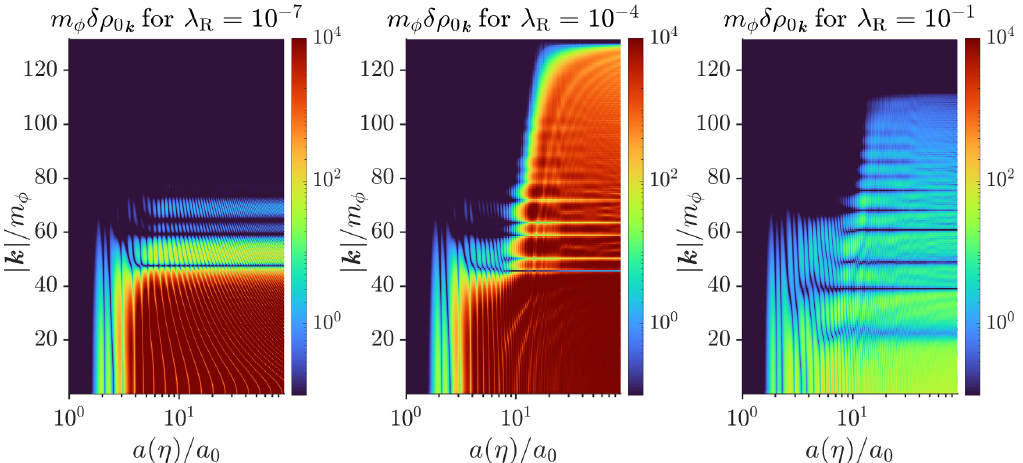
Figure 3 . The zeroth moment δρ 0 k of the two point function for λ R ∈ { 10 − 7 , 10 − 4 , 10 − 1 } with ¯ ξ R = 50 and Γ = 0